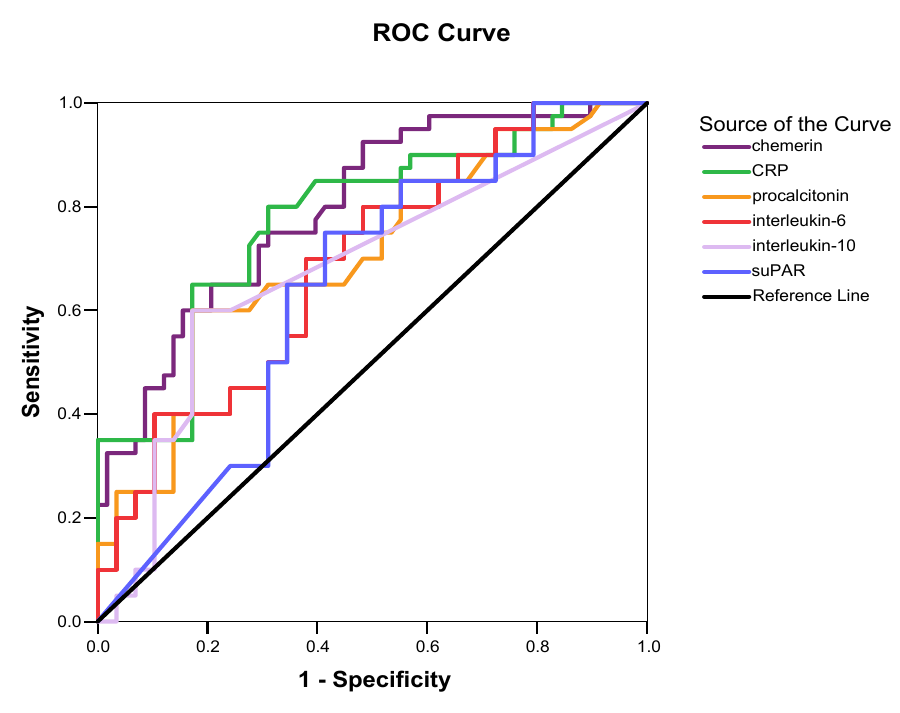
Figure 4. Area under the receiver operating characteristic curve (AUROC) distinguishing sepsis from severe sepsis in 102 patients with sepsis. Based on Table 3, circulating chemerin (AUROC > 0.78) and C-reactive protein (AUROC > 0.78) at enrollment outperform procalcitonin (AUROC > 0.71), IL-6 (AUROC > 0.69), IL-10 (AUROC > 0.68) and suPAR (AUROC > 0.64) in distinguishing sepsis from septic shock.